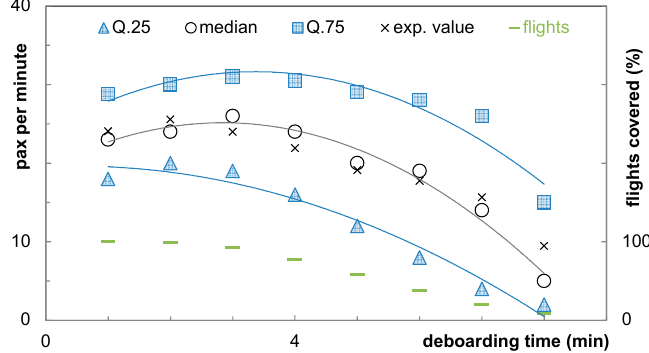
Figure 10. Deboarding outflow rates of passengers during the deboarding progress (measured at aircraft door). Coverage of flights (green dashes) is indicated on secondary y -axis.